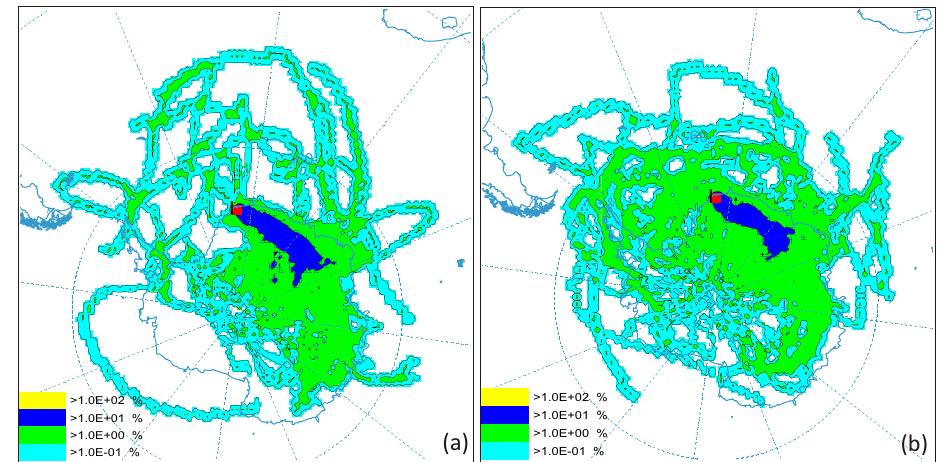
Fig. 8. The same presentation as in Fig. 7, but now for winter: (a) all 10-day back trajectories for 222 Rn activity concentrations above 1SD of the mean (>0.023Bqm − 3 , N = 257) and (b) for 222 Rn activity concentrations below 1SD of the mean ( < 0.007Bqm − 3 , N = 209).